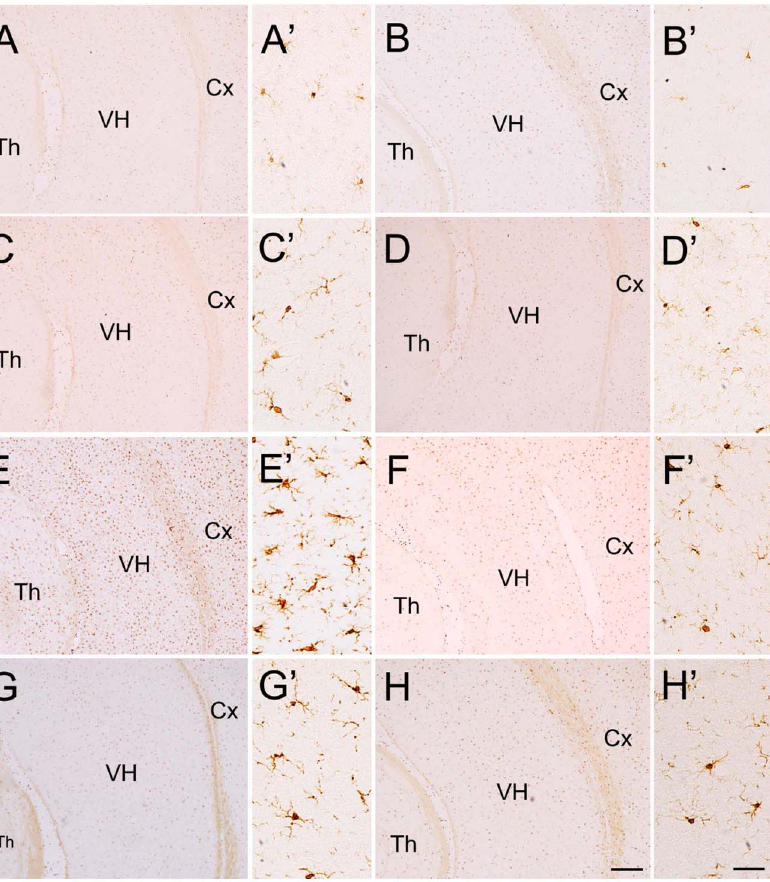
Figure 6. Iba1-immunopositive cells in VH, Cx and Th of saline- and LPS-injected rats. A small number of Iba1-immunopositive cells are present in VH, Cx and Th of rats received neonatal intrahippocampal injection of saline (A) and the saline-injected rats treated with minocycline (B), risperidone (C) or both of them (D). On the other hand, a large of number of Iba1-immunopositive cells are observed in VH, Cx and Th of the rats received neonatal intrahippocampal injection of LPS (E), but it is dramatically reduced after intragastric administration of minocycline (F), risperidone (G) or both of them (H). A’–H’ are high magnification of the ventral hippocampus in A–H, respectively. Cx, cerebral cortex; Th, thalamus; VH, ventral hippocampus. Scale bars =200 m m in H (applied from A–G) and 20 m m in H’ (applied for A’–G’).